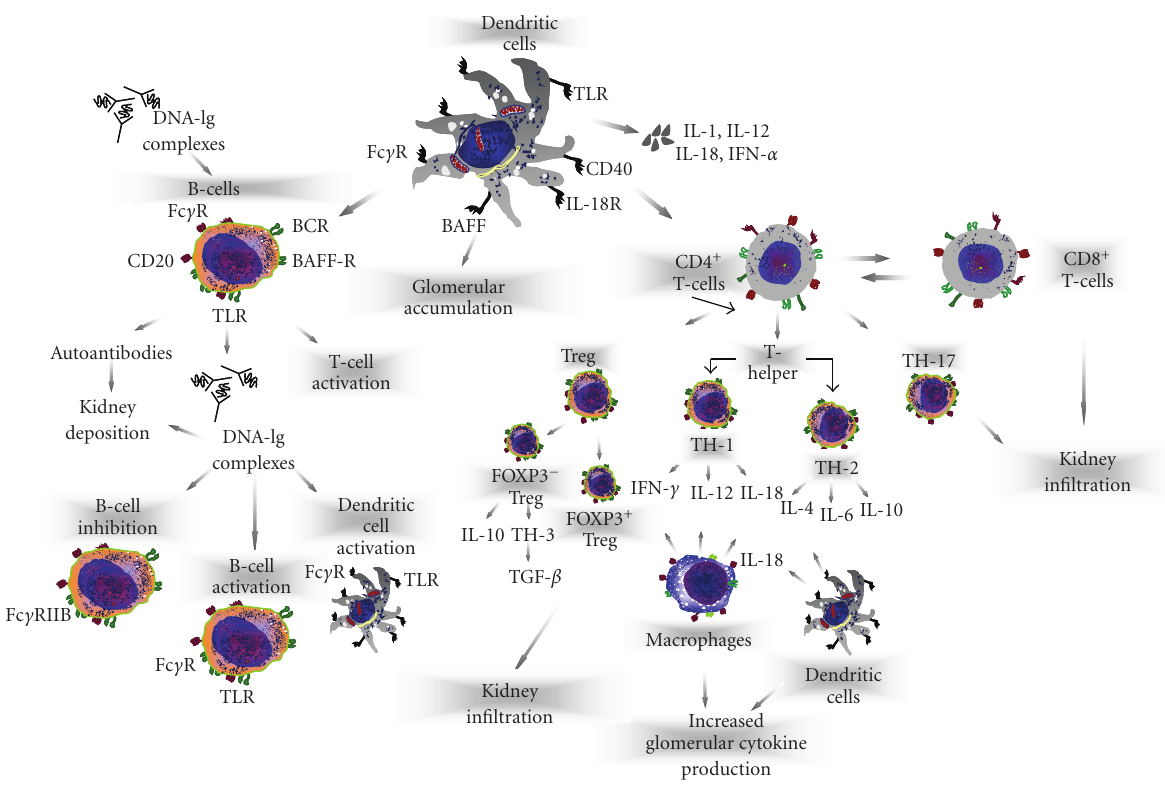
Figure 1: Representation of pathogenetic mechanisms of lupus nephritis. LN is a disease that includes several mediators of glomerular inflammation. In this context, T-cell subsets, through the production of nephritogenic cytokines or by cooperating with B-cells, macrophages, and dendritic cells promote the activation of the glomerular immune